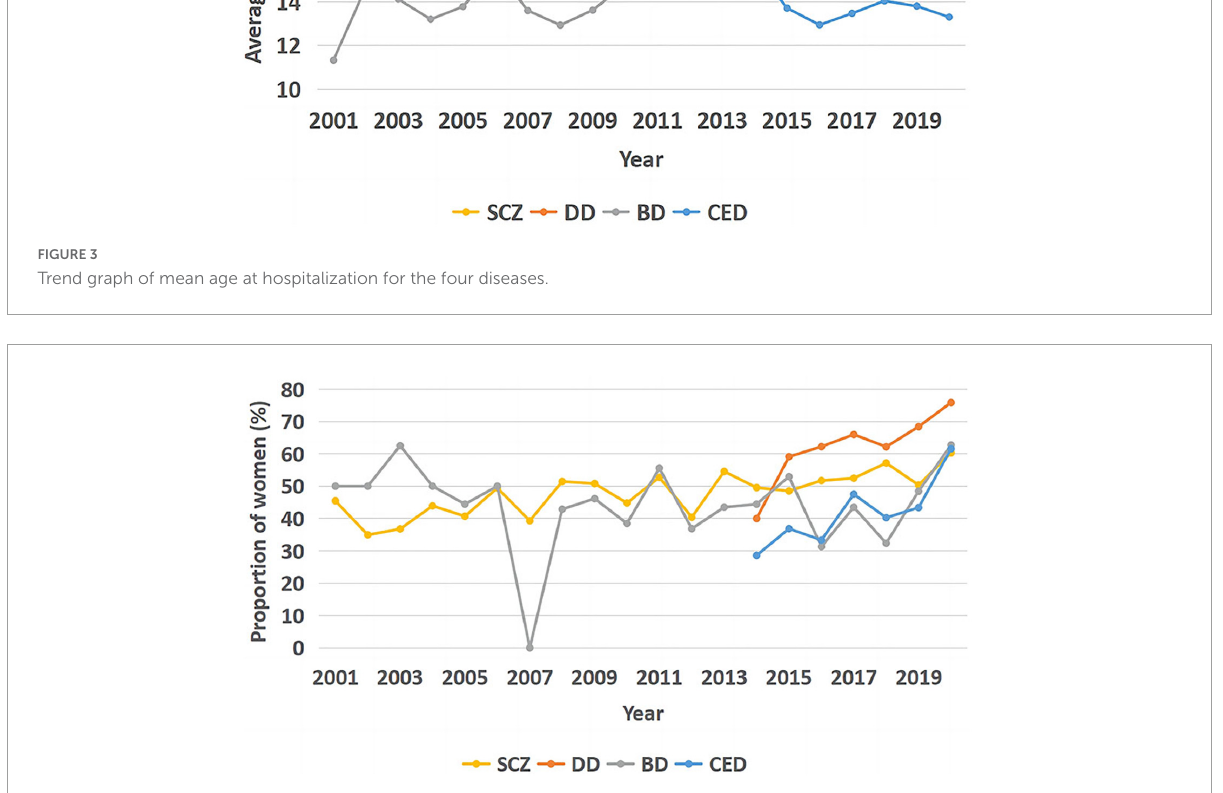
FIGURE4 Trend graph of the percentage of female patients hospitalized for the four